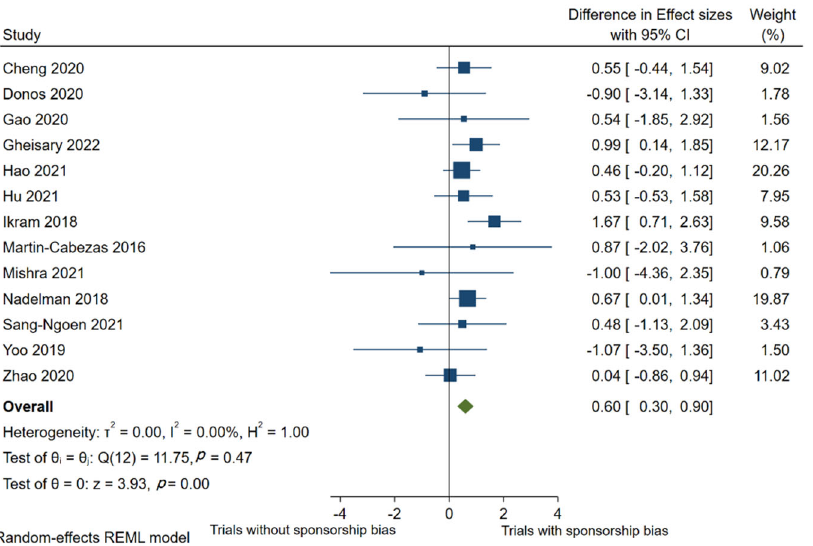
Figure 2. Difference in effect sizes between 23 trials with and 25 trials without sponsorship risk from 13 meta-analyses using meta-regression. A positive difference in effect sizes indicates that trials with sponsorship risk show more beneficial treatment effects. The effect size estimates of industry- sponsored trials were 0.6 times greater than those without industrial sponsorship (DSMD = 0.6, p < 0.001) [32–44].